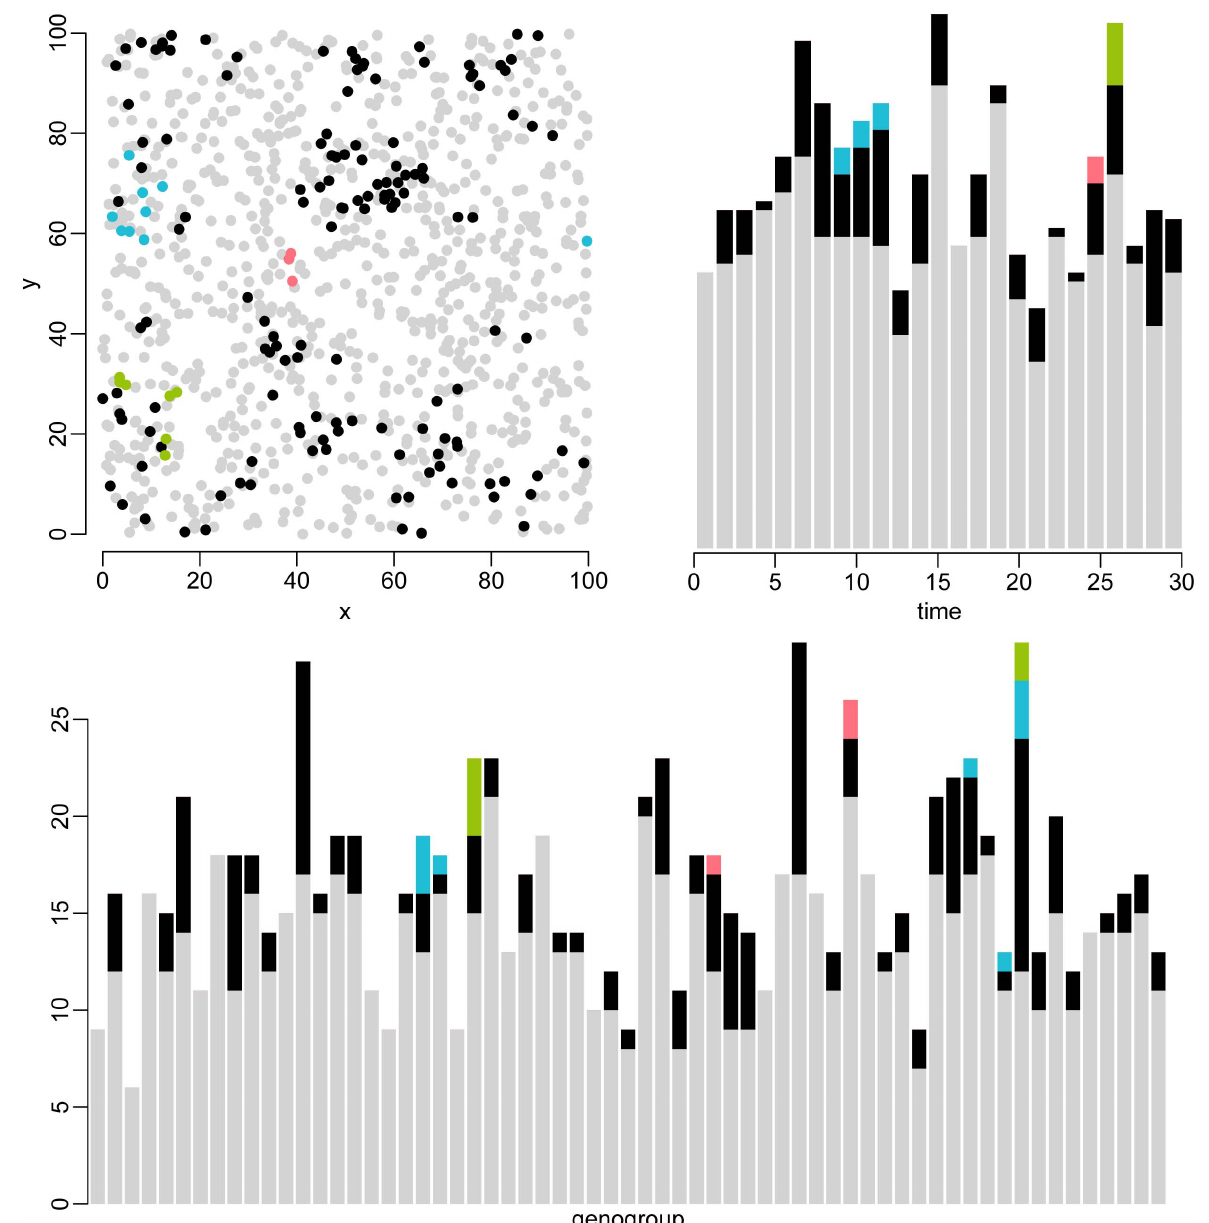
Figure 4. Graphical representation of the three data types for a typical simulation. This simulation consisted of 1019 cases of which 119 (12%) were infected by other cases. In total, there were 158 related cases belonging to 39 transmission chains, and 861 unrelated cases (gray). To visualize individual transmission chains, three chains were chosen at random and drawn in blue, green and pink. (A) Geographical location of all simulated cases. The geography is a torus, so the right side is equated with the left side, and the top side is equated with the bottom side. (B) Simulated cases over time. (C) Simulated cases have one of 2 8 =256 possible genotypes. For clarity, the distribution of cases over 64 genogroups is plotted; a genogroup is defined as a set of four genotypes that are identical up to the last two digits. The order of the genogroups on the x-axis does not reflect genetic distance. Note that outbreaks cannot be accurately identified using only one of these data types.